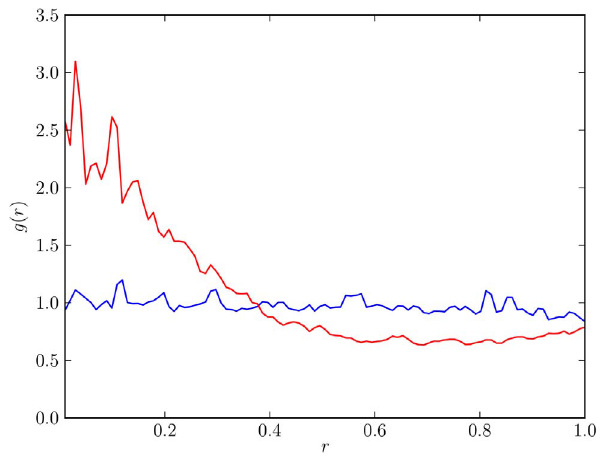
Figure 5. Pair correlation function for a virtual swarm. Comparison of the pair correlation function g ( r ) [Eq. (60)] for different values of the avoidance radius d a ~ 0 : 01 (blue curve) and d a ~ 0 : 1 (red curve). All other simulation parameters are given in table 1. For a large avoidance radius (red curve), corresponding to L & 0 : 024 [Eq. (9)] the system tends to form spatial clusters. In contrast, if the avoidance radius is low (blue curve, L & 0 : 24 ) the distribution is nearly homogeneous. a virtual swarm using two different avoidance radii d a ~ 0 : 01 (blue